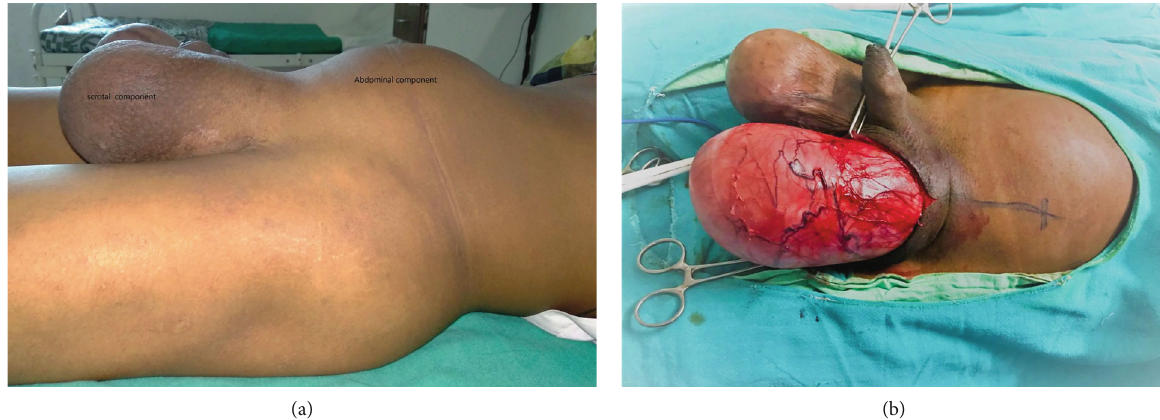
Figure 1: (a) Photograph showing abdominal and scrotal components of abdominoscrotal hydrocele. (b) Excision of sac through inguinoscrotal incision.